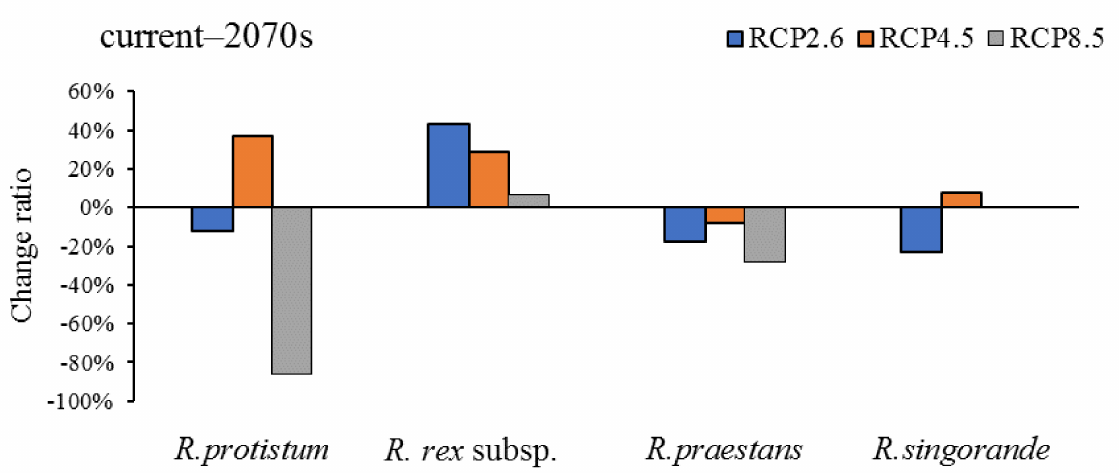
Figure 4. Change ratio of high-suitability habitat distribution range for four Rhododendron species in the 2070s under RCP 2.6, RCP 4.5, and RCP 8.5.